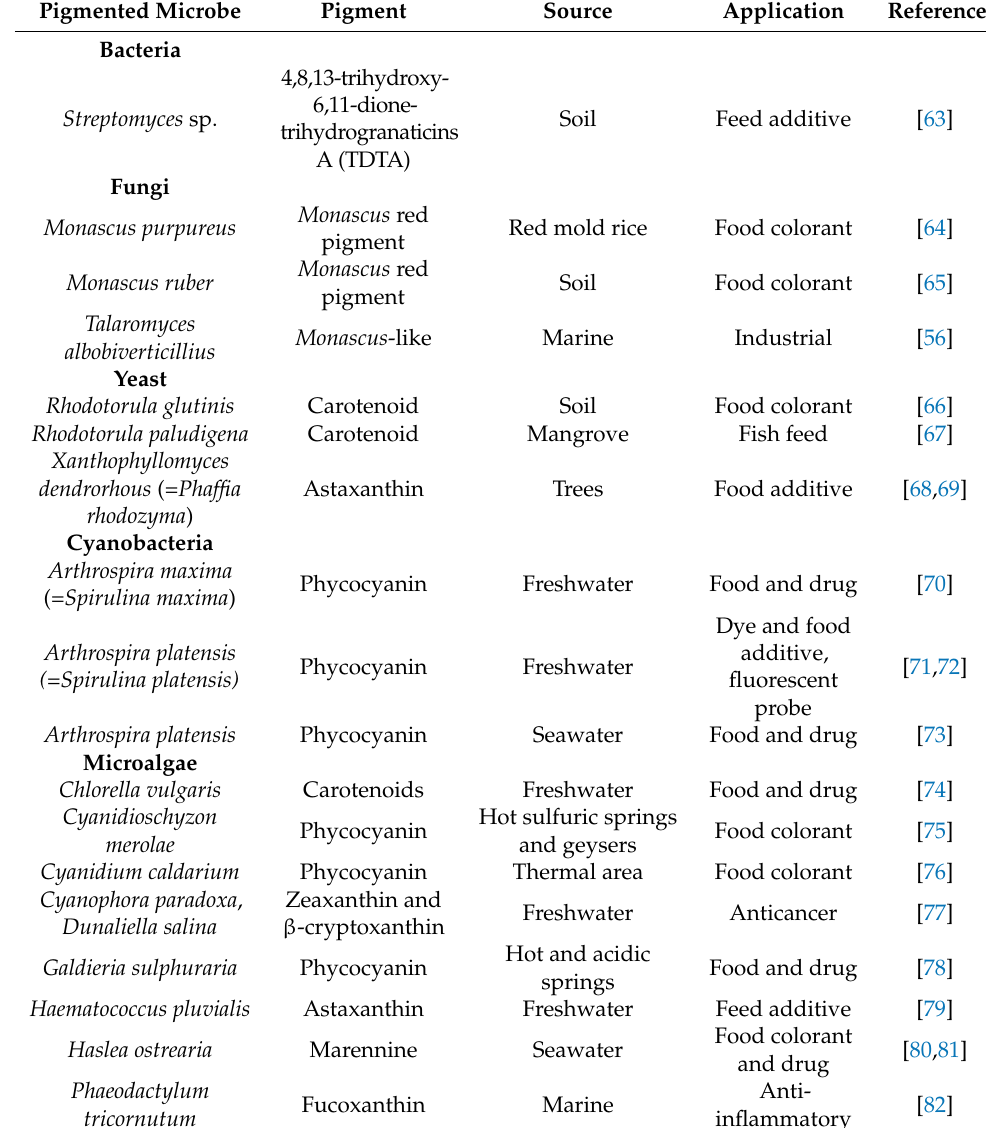
Table 1. Cont. Pigmented